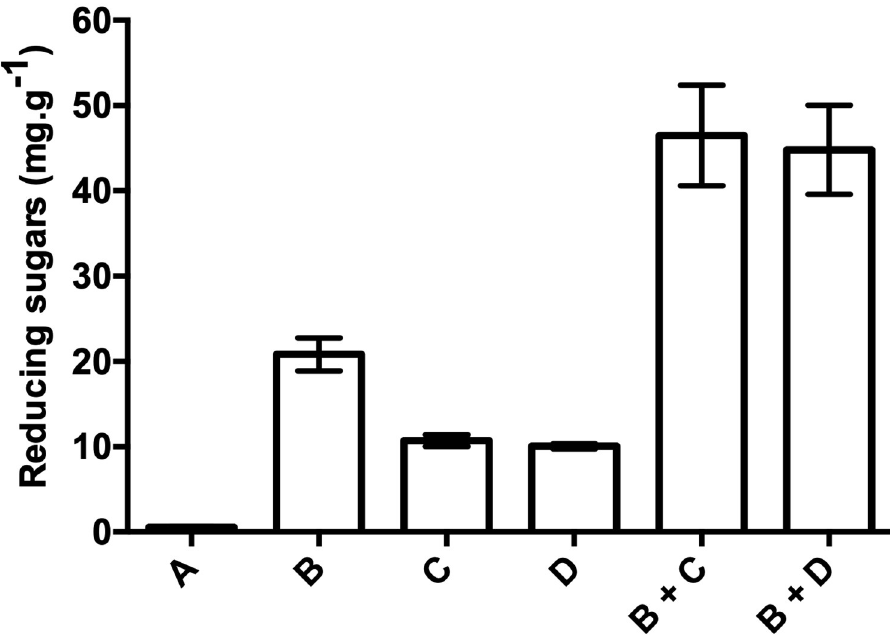
Fig 5. Comparative production of reducing sugars from empty fruit bunch using fungal enzymatic extracts alone or in combination. Reducing sugar release was observed: A) without any fungal enzymatic extract, B) with a cellulolytic extract from T . reesei , C) with a commercial laccase from T . versicolor , D) with the enzymatic extract from D . pusillus . Combinations of B+C and B+D were also tested. Standard deviation was obtained from three replicates in each condition.